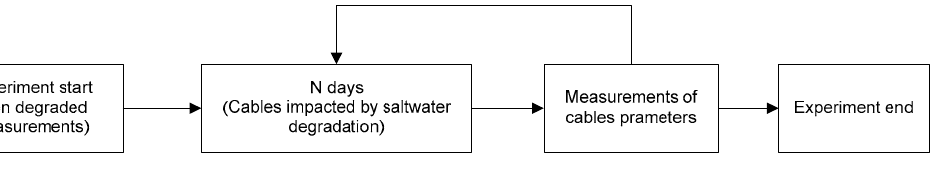
Figure 6. Scheme of the experiment.